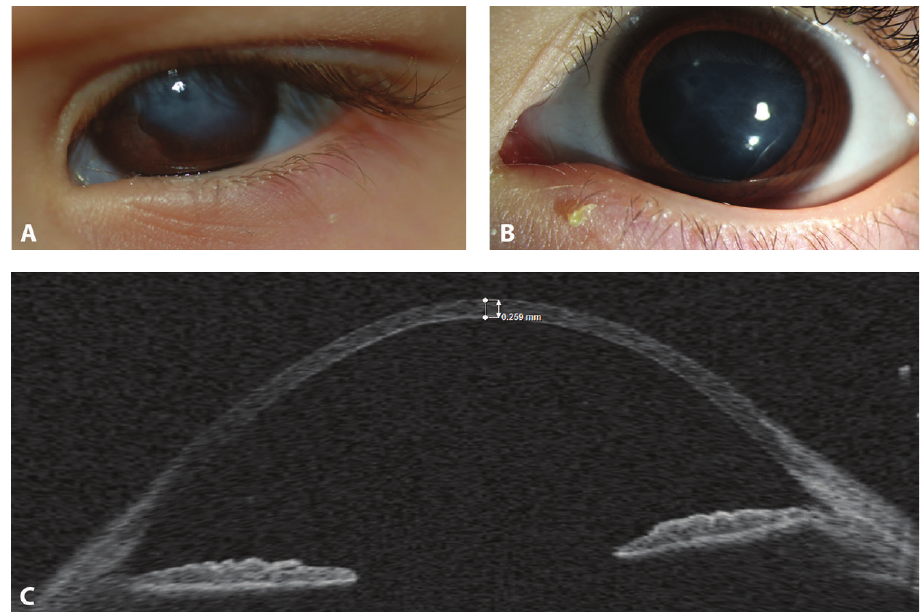
Figure 1: Acute keratoconus with hydrops in a 3-year-old child with brittle cornea syndrome. (A) Left eye three months after acute keratoconus with already clearing corneal cloudiness. (B) Seven months after acute keratoconus only little subepithelial scars remained. (C) Optical coherence tomography (OCT) at 7 months after acute hydrops demonstrated steepness and thinning of cornea. Corneal thickness centrally was 259 𝜇